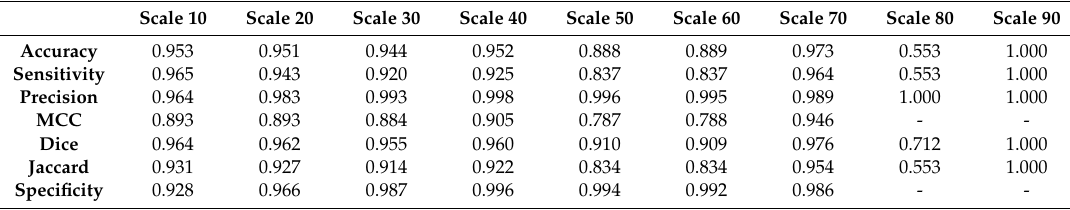
Table 2. Segmentation analysis results after the application of the Gram–Schmidt pansharpening